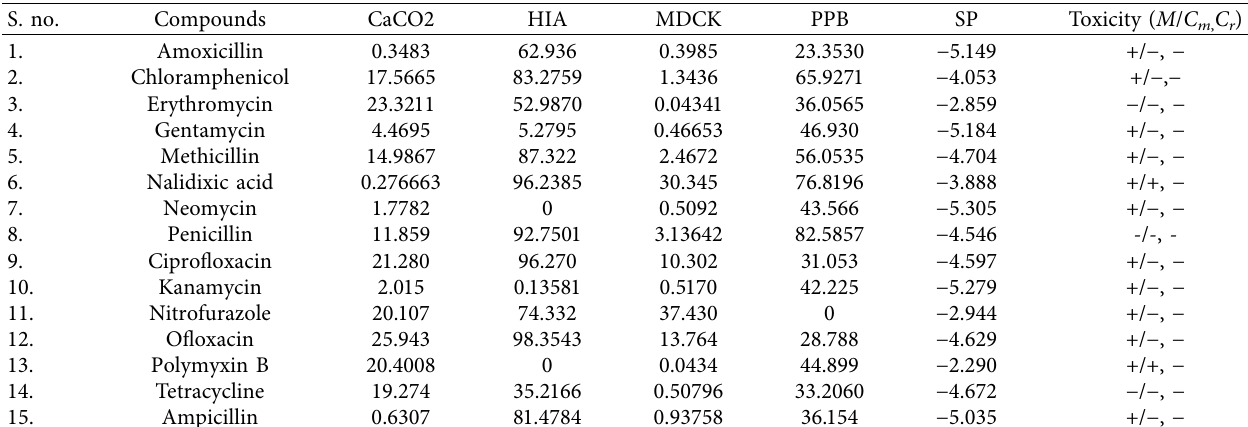
Table 11: ADME/Tox prediction of the diferent used